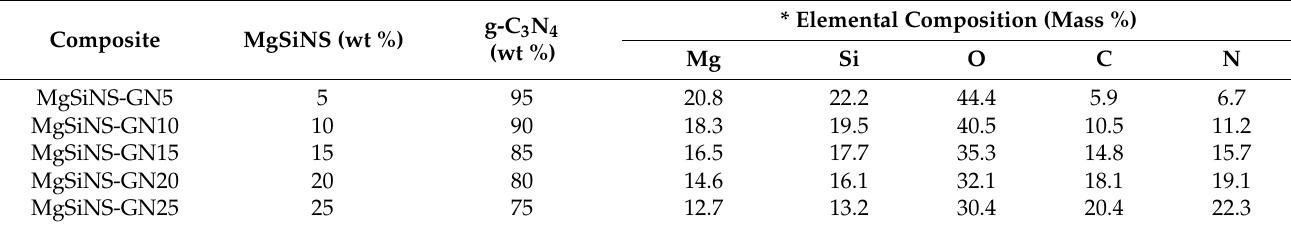
Table 2. Composition of MgSiNS and g-C 3 N 4